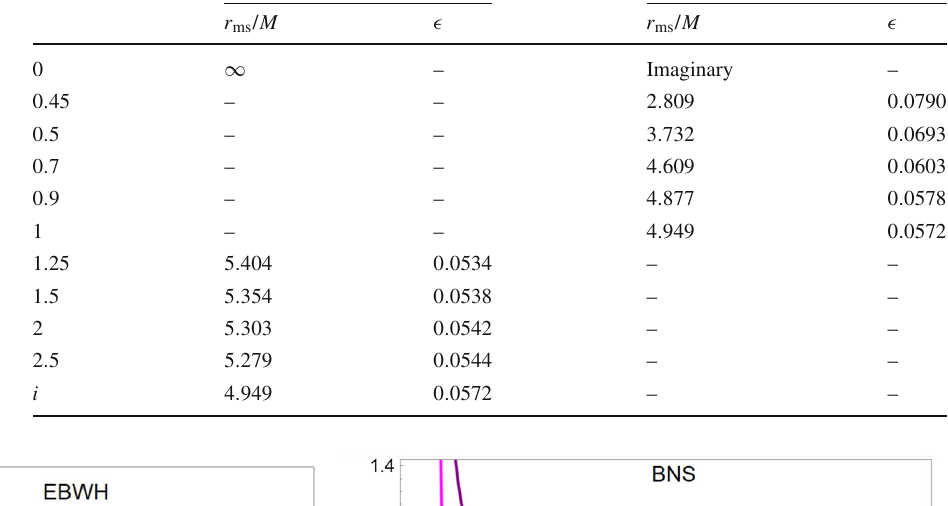
Table 1 The r ms and the efficiency (cid:2) for EBWH, BNS and SBH. Note that γ = 1 in BNS and γ = i in EBWH respectively yield SBH quantities, while γ = 0 yields the values for massless BNS and EBWH respectively